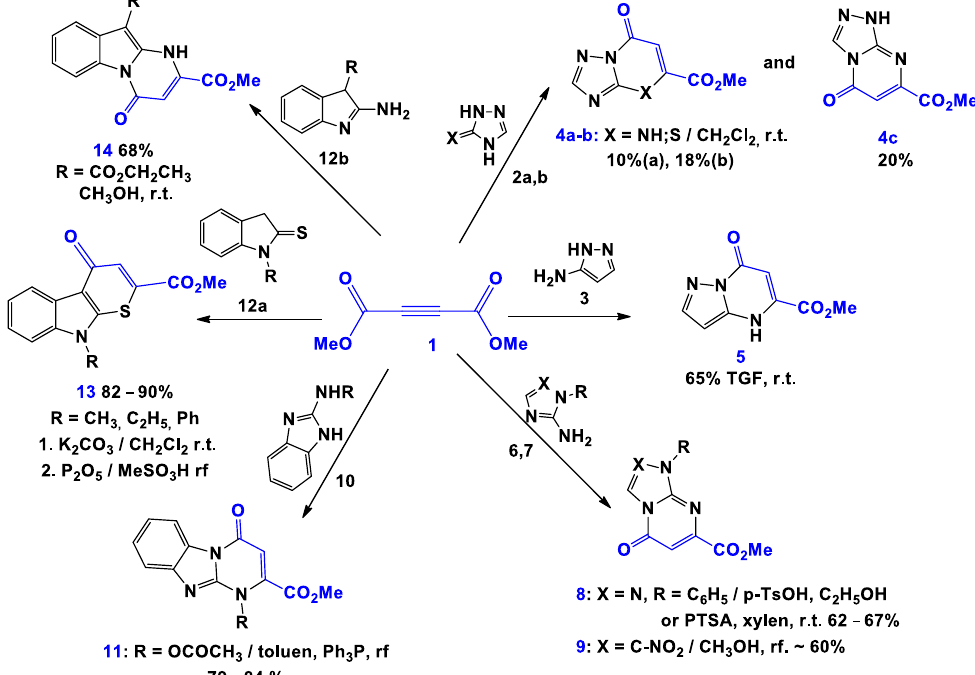
Scheme 1. Interaction of DMAD ( 1 ) with N,N- and S,N-dinucleophiles.